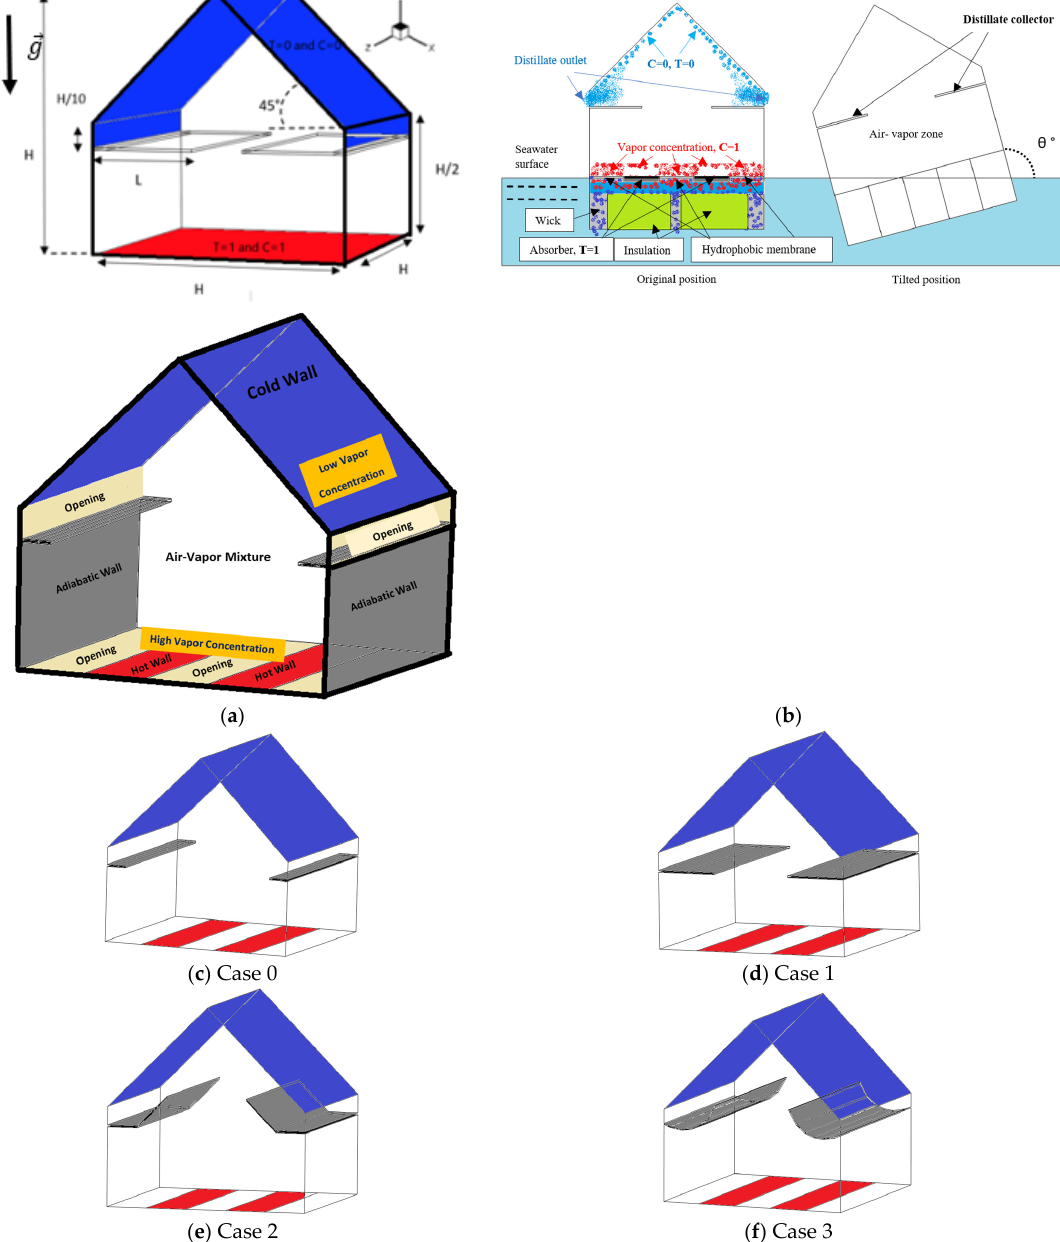
Figure 1. Physical Models and different designs of baffles studied. ( a ) shows the model of the